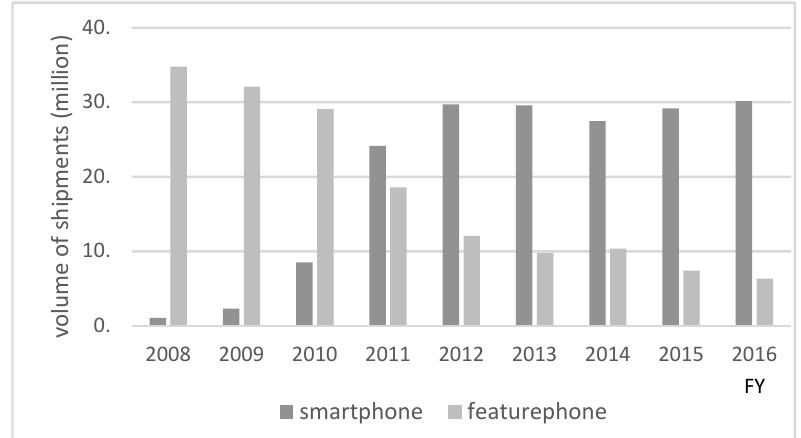
Figure 2. The mobiles phone’s volumes of shipments (smart phone and feature